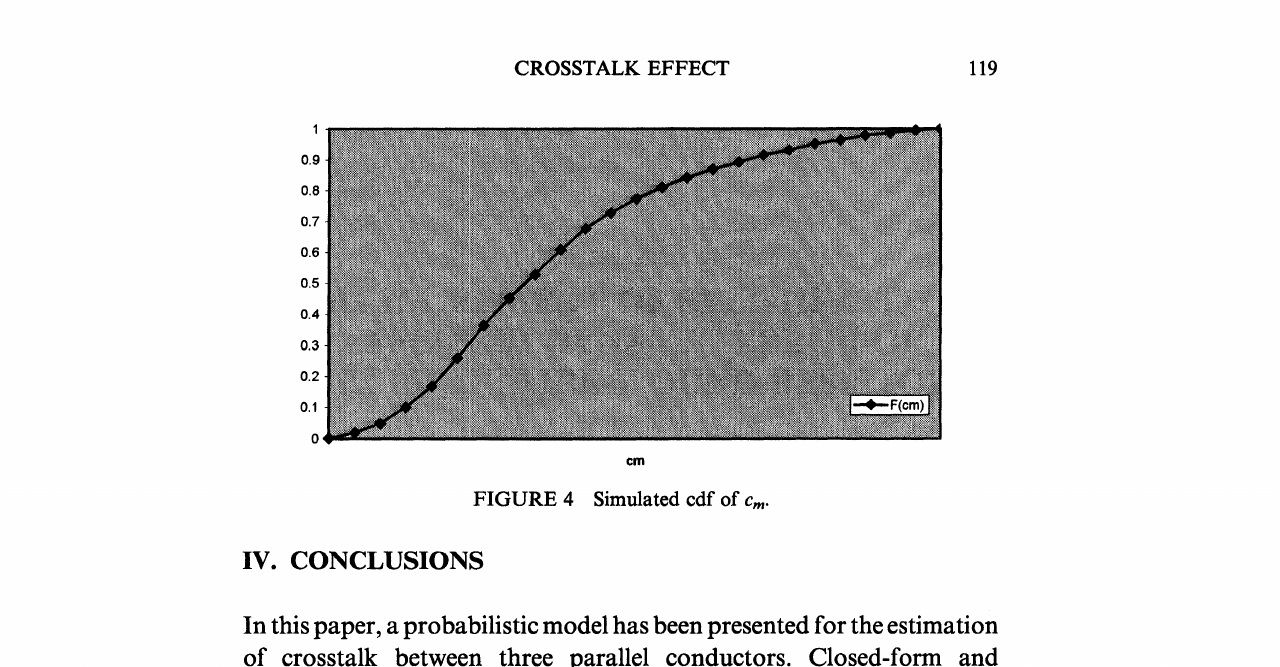
FIGURE 4 Simulated cdf of